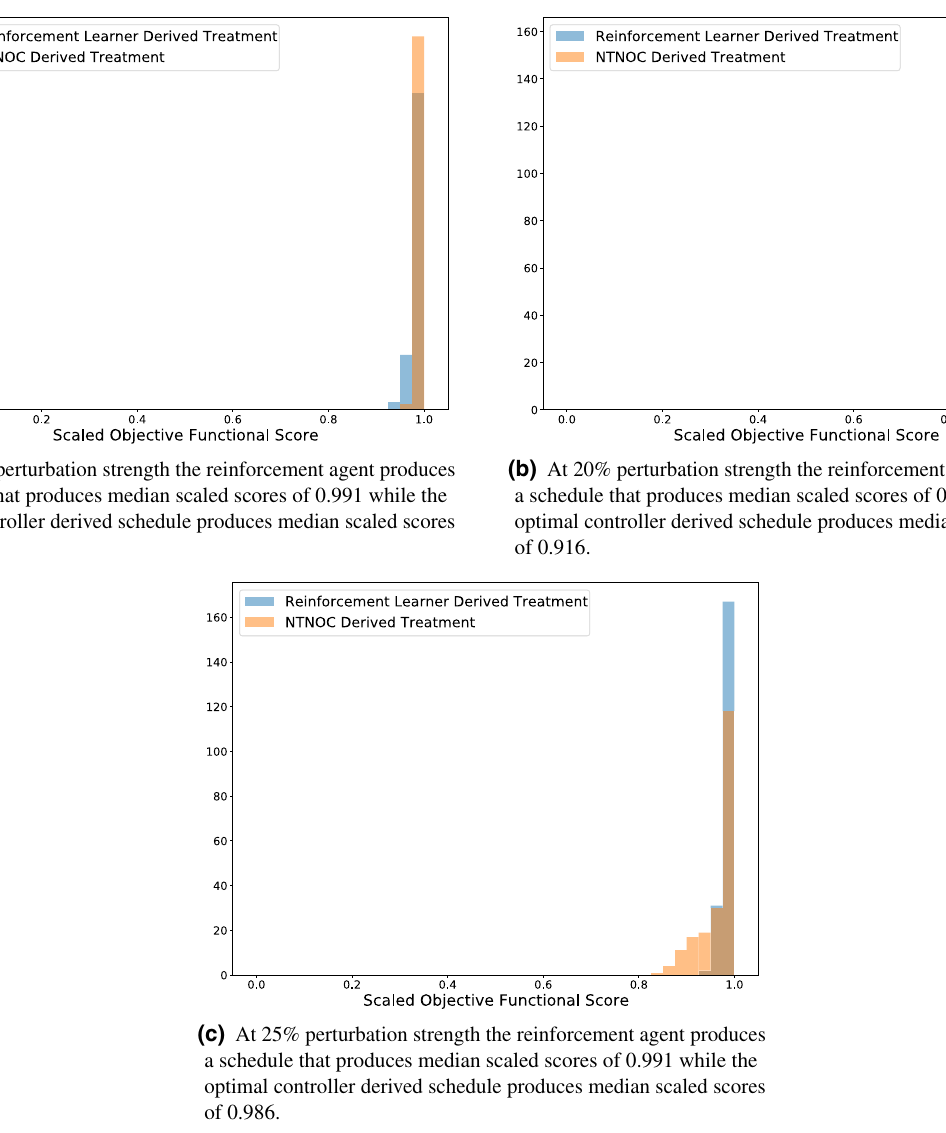
Figure 10. Histograms of the scores achieved by the various agents on the 200 testing virtual patients. Bin sizes were chosen to correspond to 0.025. In particular, while the reinforcement learning agent is more robust towards perturbation in parameter values at the 20% and 25% perturbation strength, the nearest neighbour optimal controller produces schedules within 5% of the theoretical maximum at the 15% perturbation